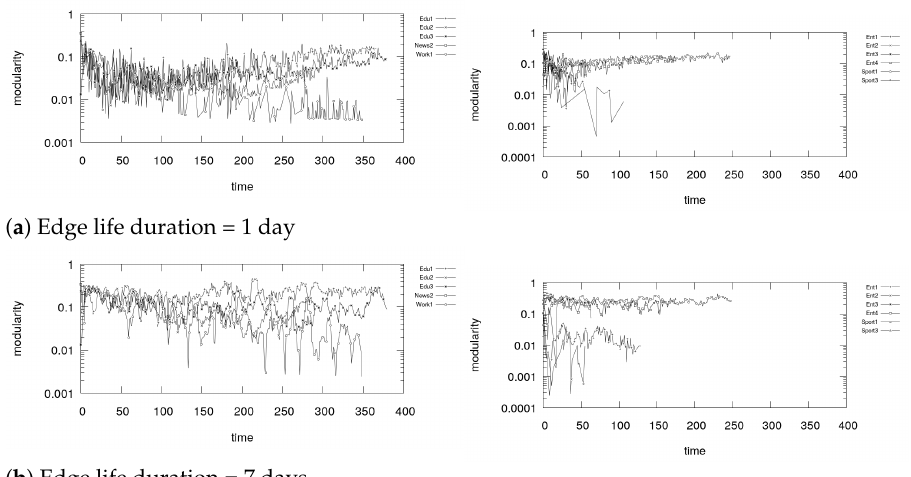
Figure 22. Modularity of communities detected by DEMON.